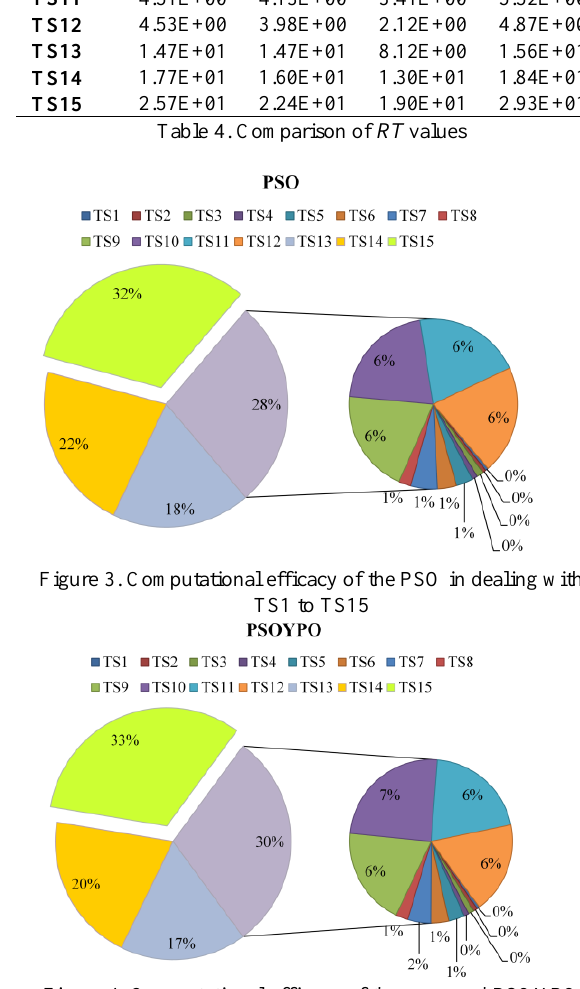
Figure 4. Computational efficacy of the proposed PSOYPO in dealing with TS1 to TS15